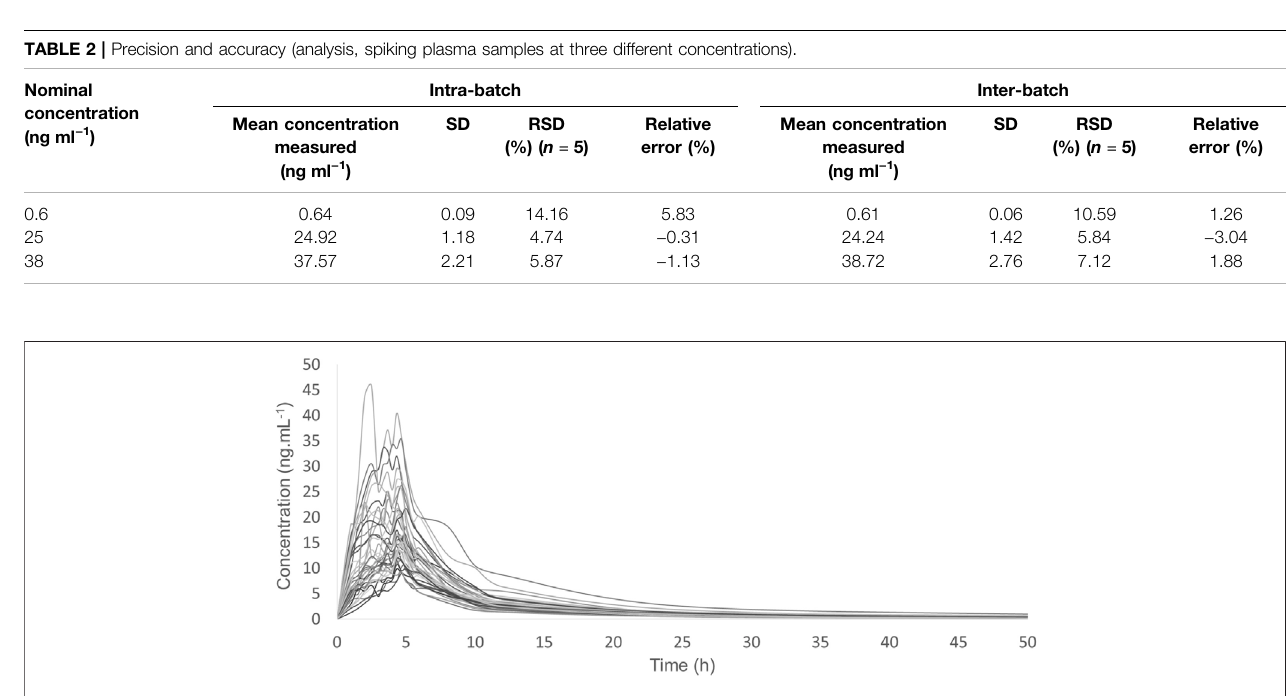
FIGURE 2 | Plasma concentration – time curves of rosuvastatin reference formulation administered to 40